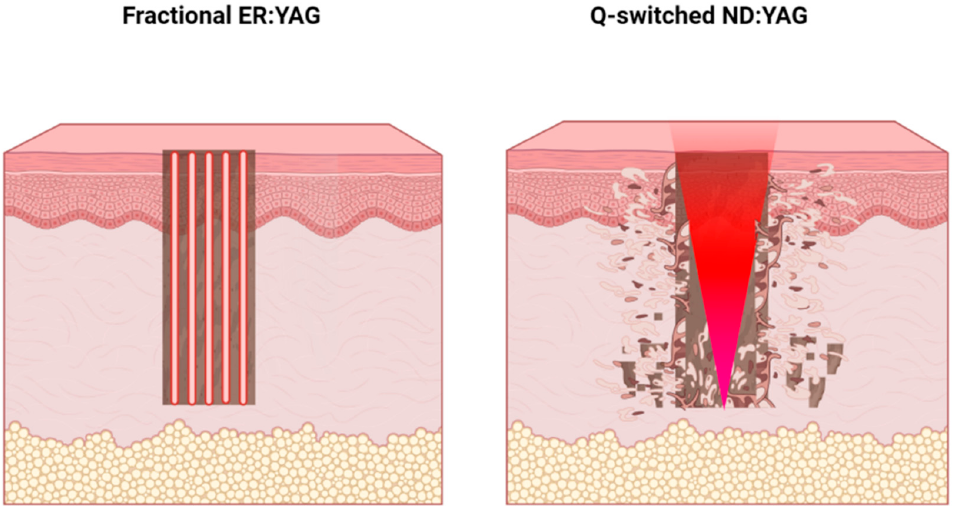
Figure 5. Schematic illustrating the laser–tissue interaction for the fractional Erbium: YAG 2940 nm laser ( left ) and Q-switched Nd: YAG 1064 nm lasers ( right ).